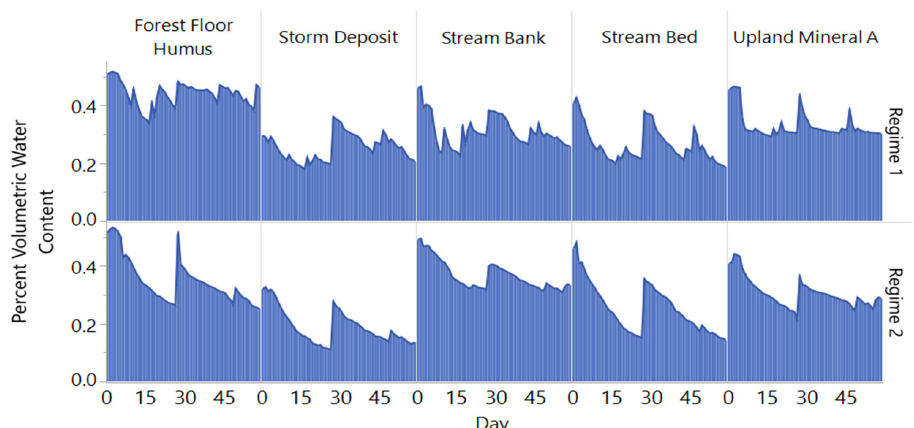
Figure 2. Percent volumetric water content for the five sources across the two moisture regimes: regime 1—continuously moist and regime 2—dry–wet cycle.